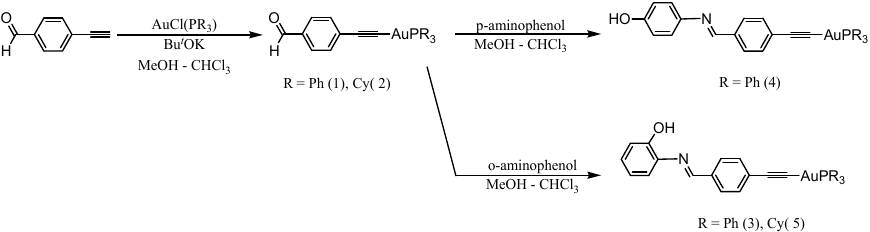
Figure 3. Synthesis of the gold(I) alkynyl containing Schiff bases.